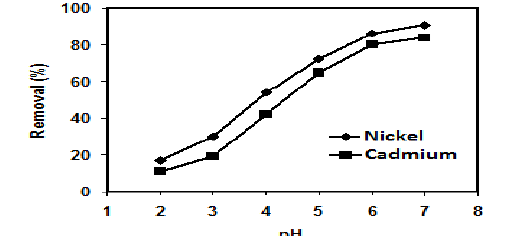
Fig. 5. Effect of adsorbent dosage on heavy metal removal by PPI dendrimer (C 0 =100 mg/L, pH=7, T=298